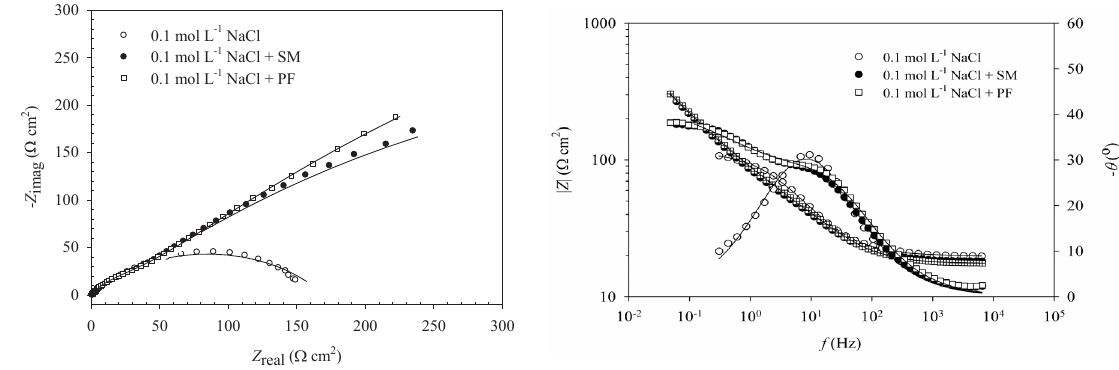
Figure 3: Nyquist and Bode plots of Fe electrode recorded at the E OCP in 0.1 mol L − 1 NaCl solution, containing SM and PF of Satureja montana L.